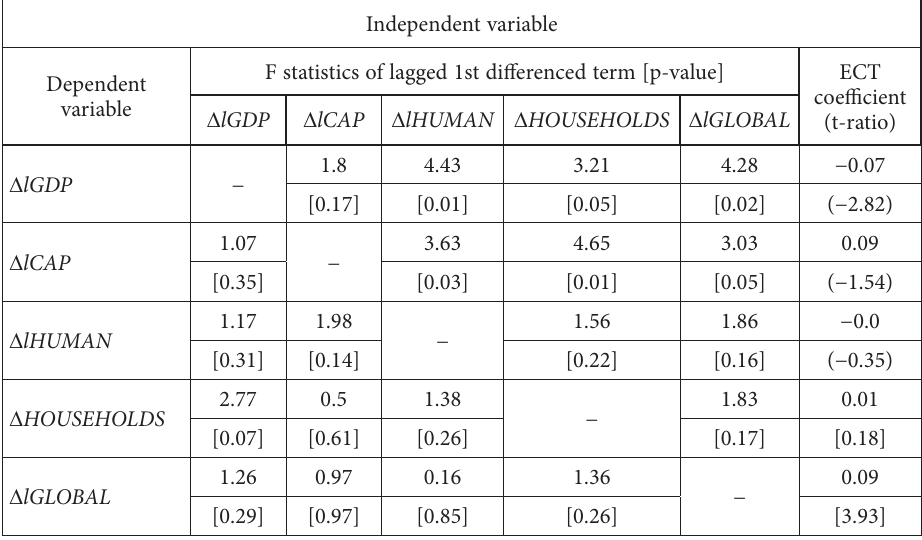
Table 6. Granger causality test results (with lHOUSEHOLDS) (source: authors’ calculation) Independent